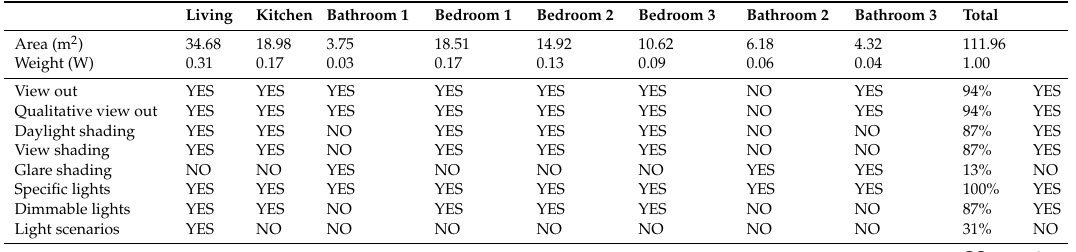
Table 10. Calculation of the weights of the rooms (W) and of the qualitative score